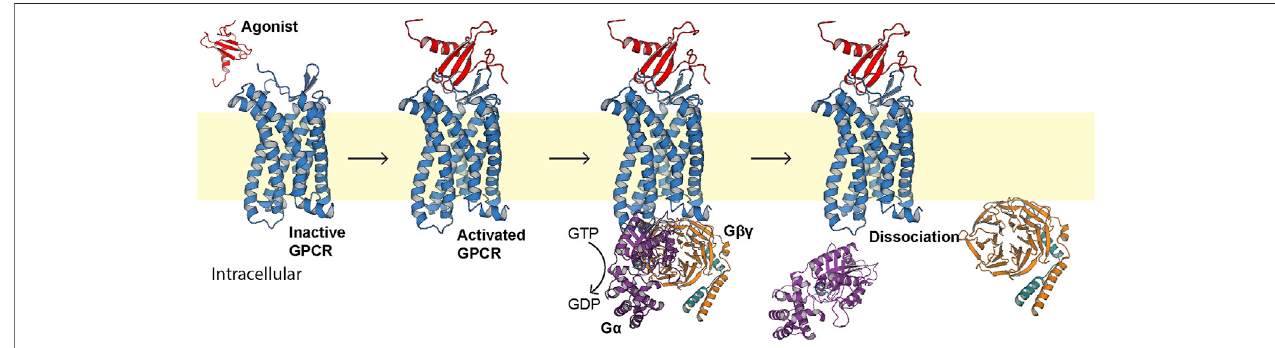
FIGURE1| Generalized fi rststepofGPCR signaltransduction.Theextracellularagonist(red, PDBID1EOT)(Crumpet al.,1998)bindstotheorthosteric pocketof the GPCR (blue) to elicit a conformational change recognized intracellularly by the heterotrimeric G protein (PDB ID 1GP2) (Wall et al., 1995). The G protein binds, exchanges bound GDP for GTP, and the α subunit (purple) dissociates from the β γ subunits (orange and teal,